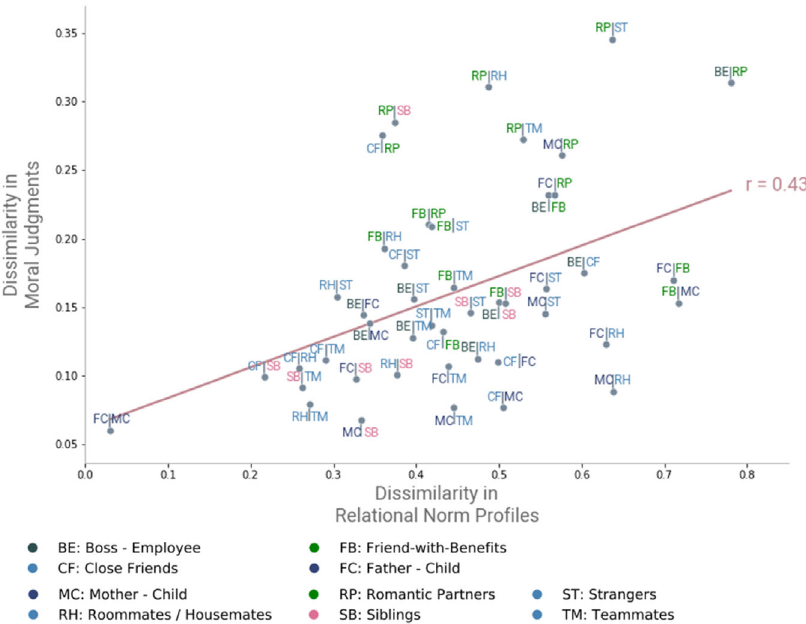
Fig. 6 Correlation between dyad dissimilarity in relational norms and dissimilarity in moral judgments. Scatterplot showing the predicted correlation in K-S distance between each pair of relationship dyads in relational norm space (x-axis) and the K-S distance between those same dyads in moral judgment space (y-axis). Spearman ’ s r = .43, p = .003. Note that the color of each relationship re fl ects the cluster in which it is located from Fig. 3. Source data are provided as a Source Data fi